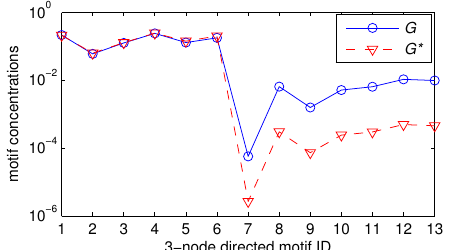
Figure 1. Motif statistics of the graph G and a sampled graph G ∗ (the numbers are the motif